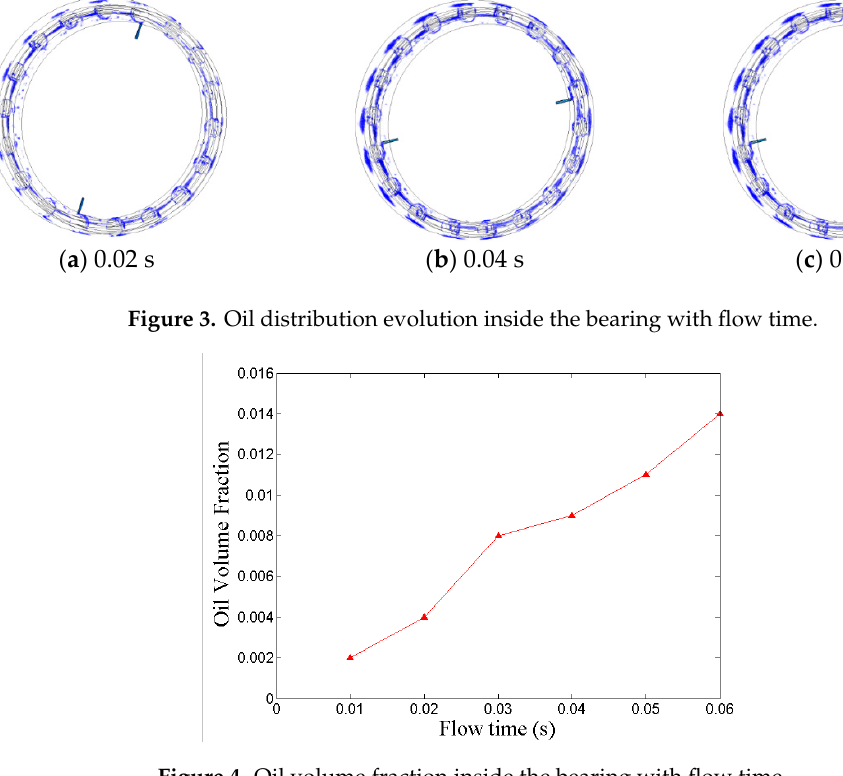
Figure 4. Oil volume fraction inside the bearing with flow time.